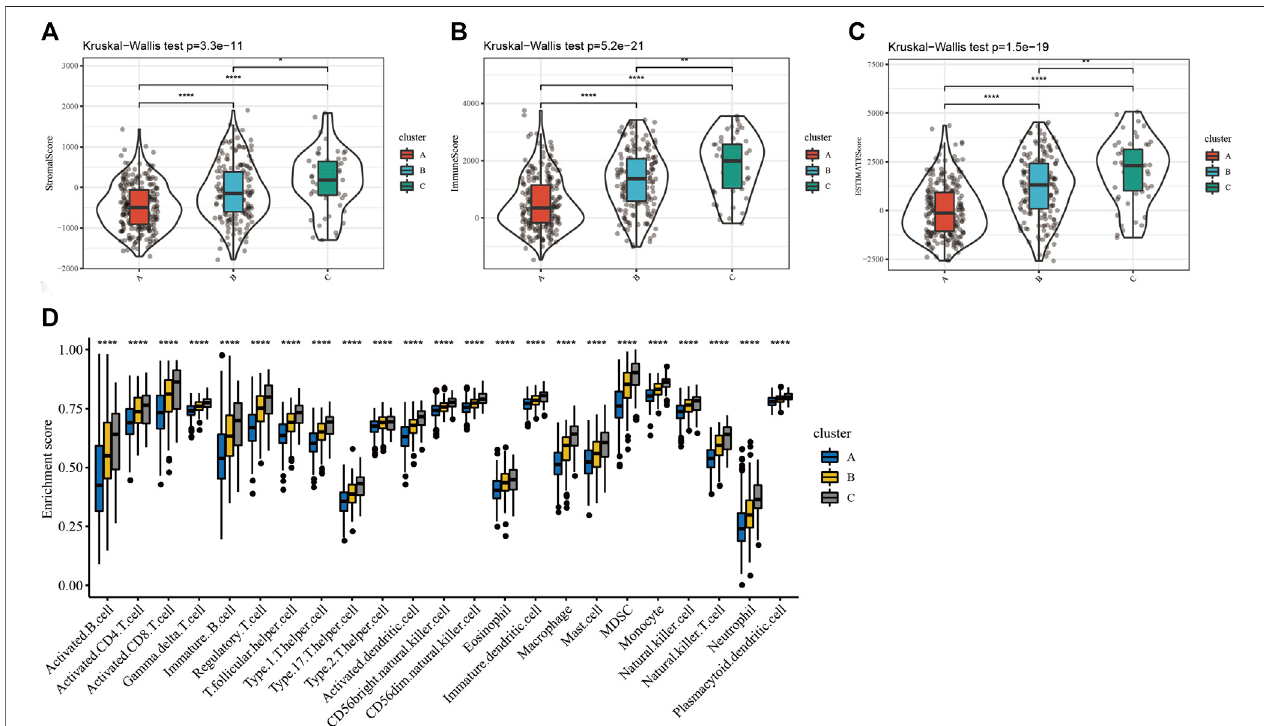
FIGURE 3 | The differences of immune in fi ltration in the three clusters of SKCM patients were statistically signi fi cant. (A – C) The results of StromalScore, ImmuneScore, and ESTIMATEScore in the three clusters were as follows: cluster C > cluster B > cluster A. (D) The 23 kinds of immune cells of TME in the three clusters (**** p < 0.0001; *** p < 0.001; ** p < 0.01; * p <